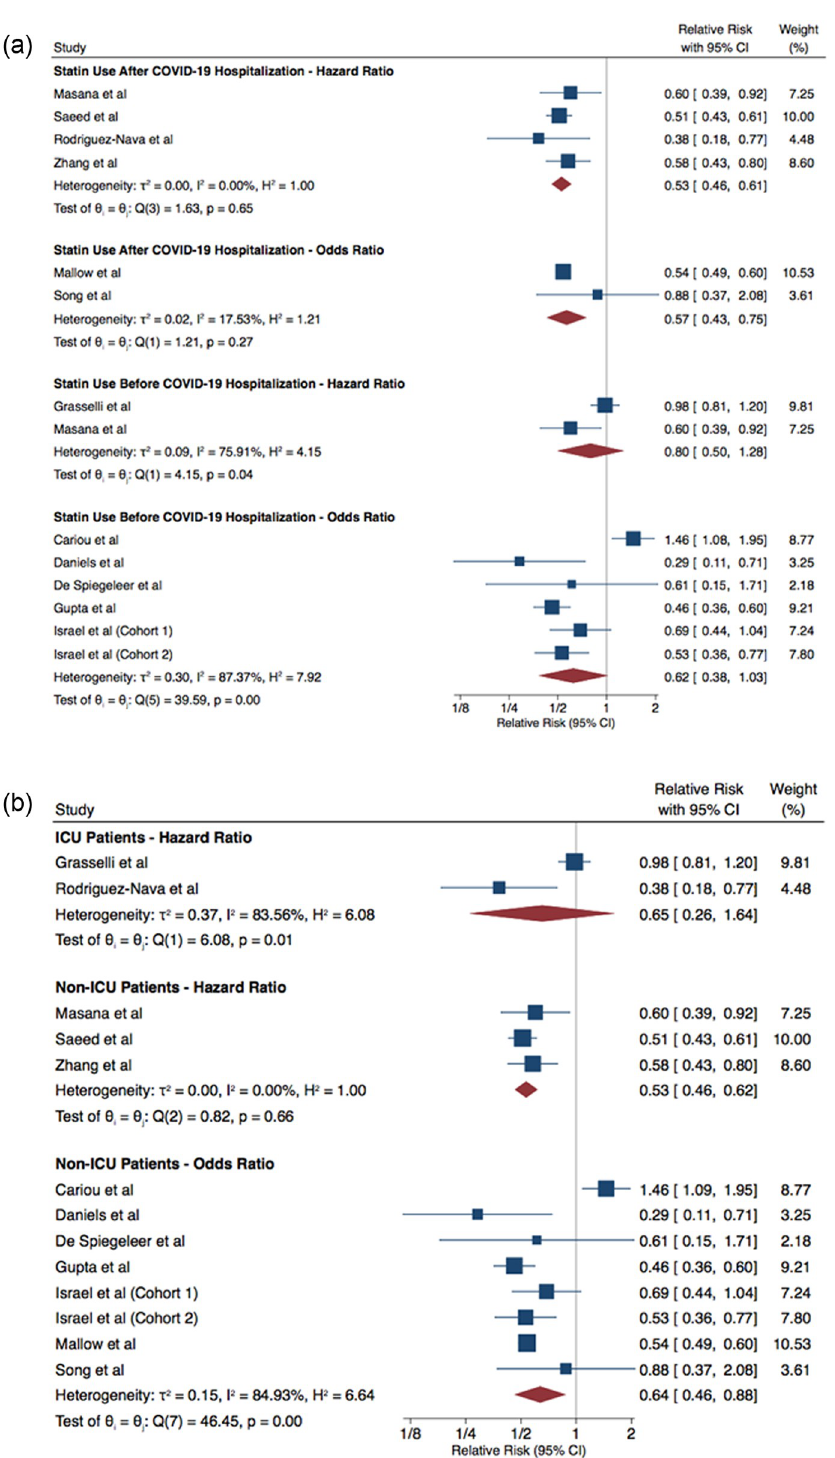
Fig 1. COVID-19 patients who used statins vs did not use statins—Mortality analysis. a By Statin Usage, b By ICU/ Non-ICU Patients.